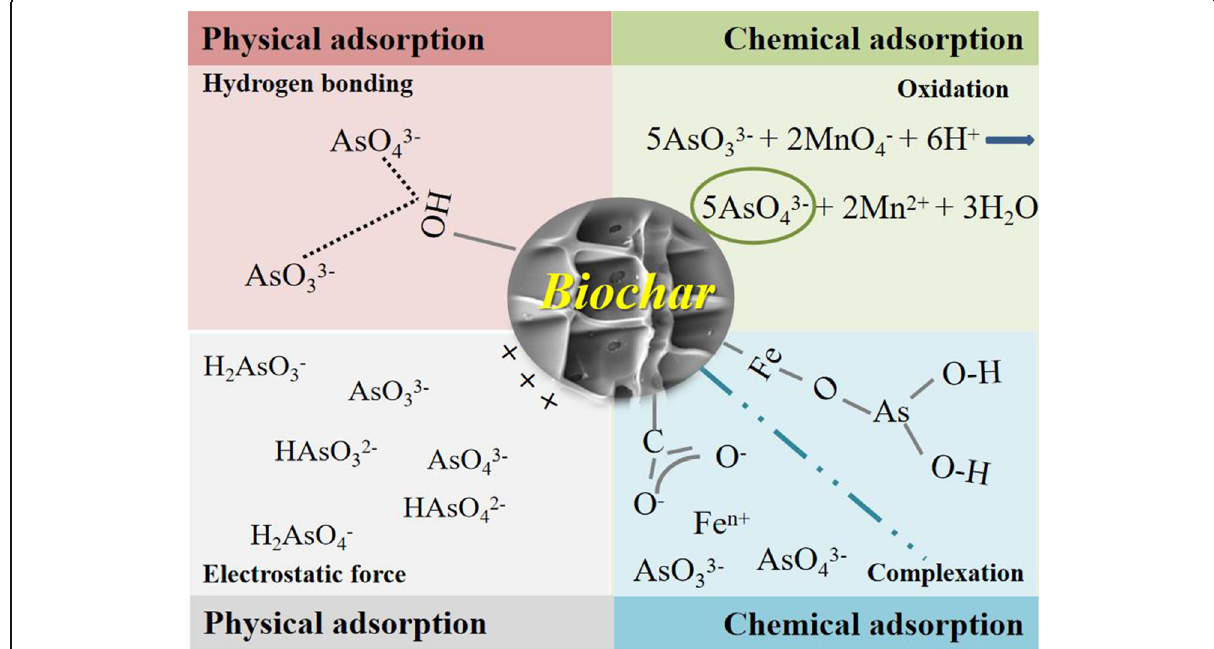
Fig. 13 Schematic diagram of reaction mechanism analysis